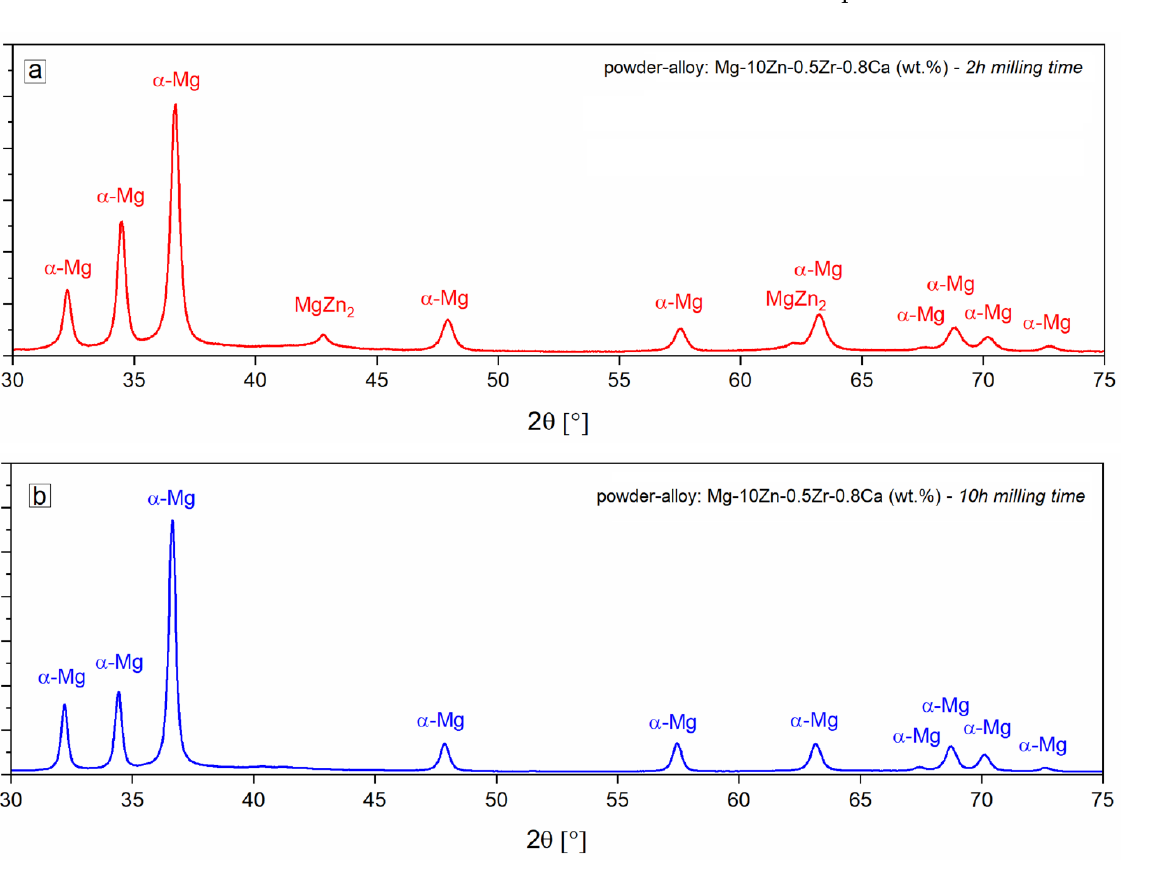
Figure 2. XRD analysis of the powder-alloy samples processed by mechanical alloying for 2 h milling time ( a ), and for 10 h milling time ( b ).